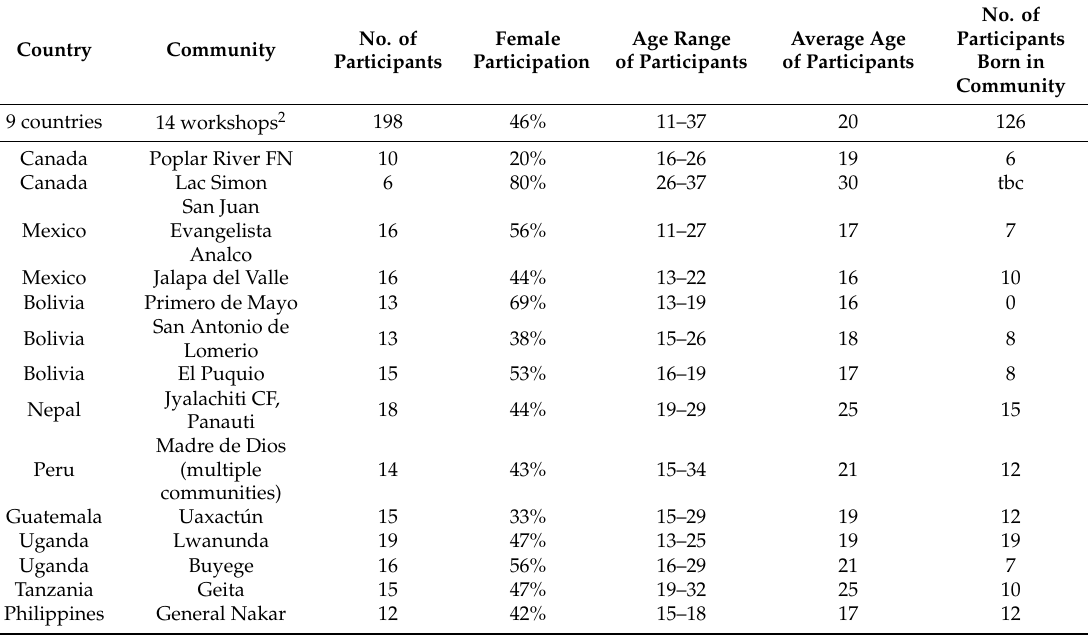
Table 1. Workshop locations and participant